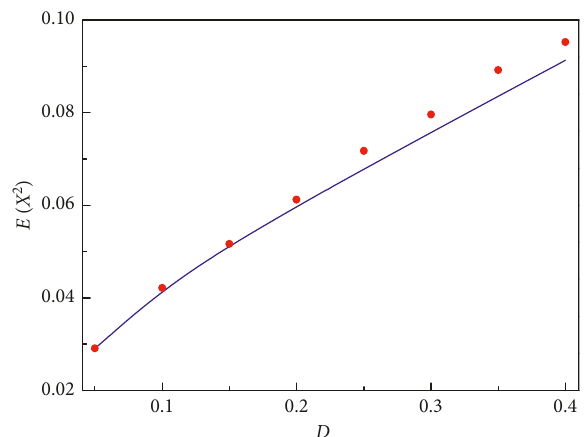
Figure 5: The mean square displacement E [ X 2 ] vs. excitation parameter α (solid line: the analytical results; discrete symbols: Monte Carlo simulation results).